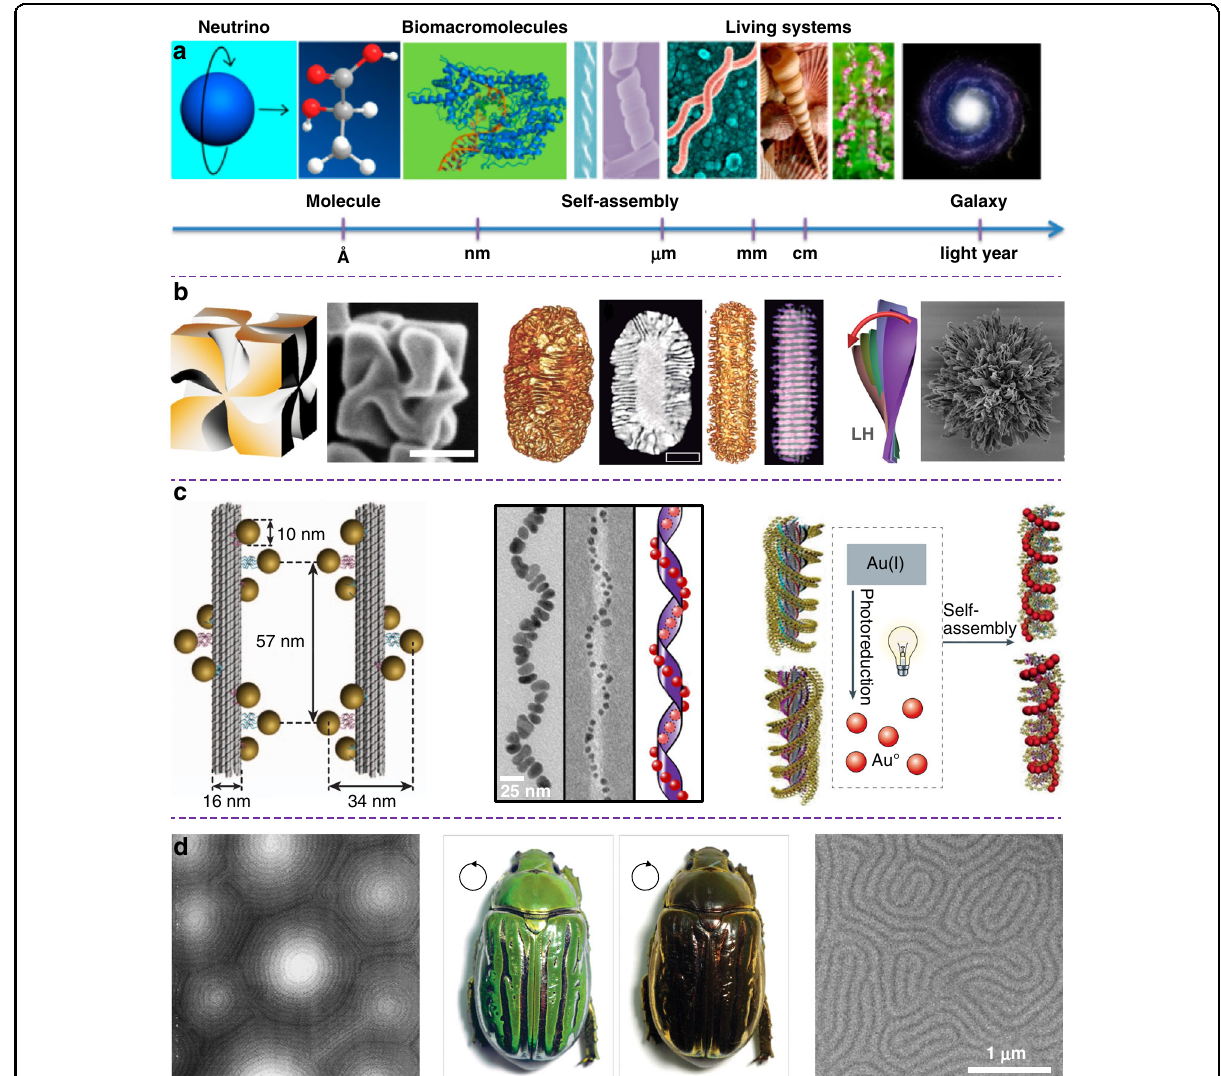
Fig. 1 Chirality at the nanoscale. a Chirality at various hierarchical scales. Reproduced with permission from ref. 2 . Copyright 2015, American Chemical Society. b Chiral nanomaterials with intrinsic chirality prepared by enantioselective synthesis. Left: Reproduced with permission from ref. 17 . Copyright 2018, Springer Nature. Middle: Reproduced with permission from ref. 21 . Copyright 2020, AAAS. Right: Reproduced with permission from ref. 18 . Copyright 2020, AAAS. c Chiral nanomaterials based on different soft templates (left-to-right): DNA-, peptide-, and chiral gelator-directed self- assembly of achiral nanoparticles. Left: Reproduced with permission from ref. 23 . Copyright 2012, Springer Nature. Middle: Reproduced with permission from ref. 26 . Copyright 2016, American Chemical Society. Right: Reproduced with permission from ref. 37 . Copyright 2014, American Chemical Society. d Chiral liquid-crystalline nanoarchitecture observed in beetles and biomimetic systems. (Left) Atomic force microscopy image of the beetle exoskeleton. (Middle) Beetle exoskeletons under left- and right-handed circularly polarized light. (Right) Scanning electron microscope image showing the self-assembly of platinum nanoparticles around the fi ngerprint of a cholesteric liquid-crystalline template. Left and middle: Reproduced with permission from ref. 85 . Copyright 2009, AAAS. Right: Reproduced with permission from ref. 89 . Copyright 2002, Springer